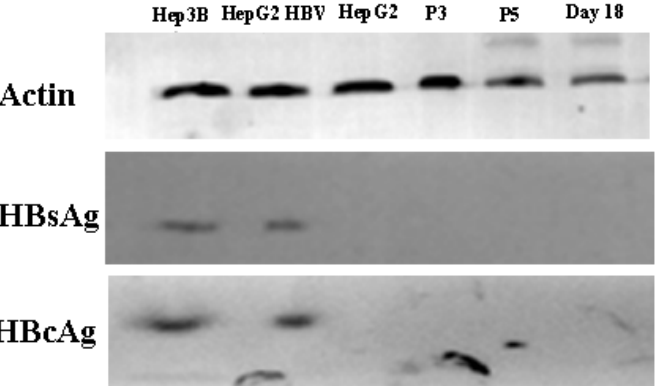
Figure 11. Western blot analysis results. HepG2 cells served as negative controls. Hep3B cells were positive controls. HepG2, the 3rd and 5th generation AD-MSCs and the induced AD-MSCs on day 18 were infected by HBV serum for 48 h. β -actin as